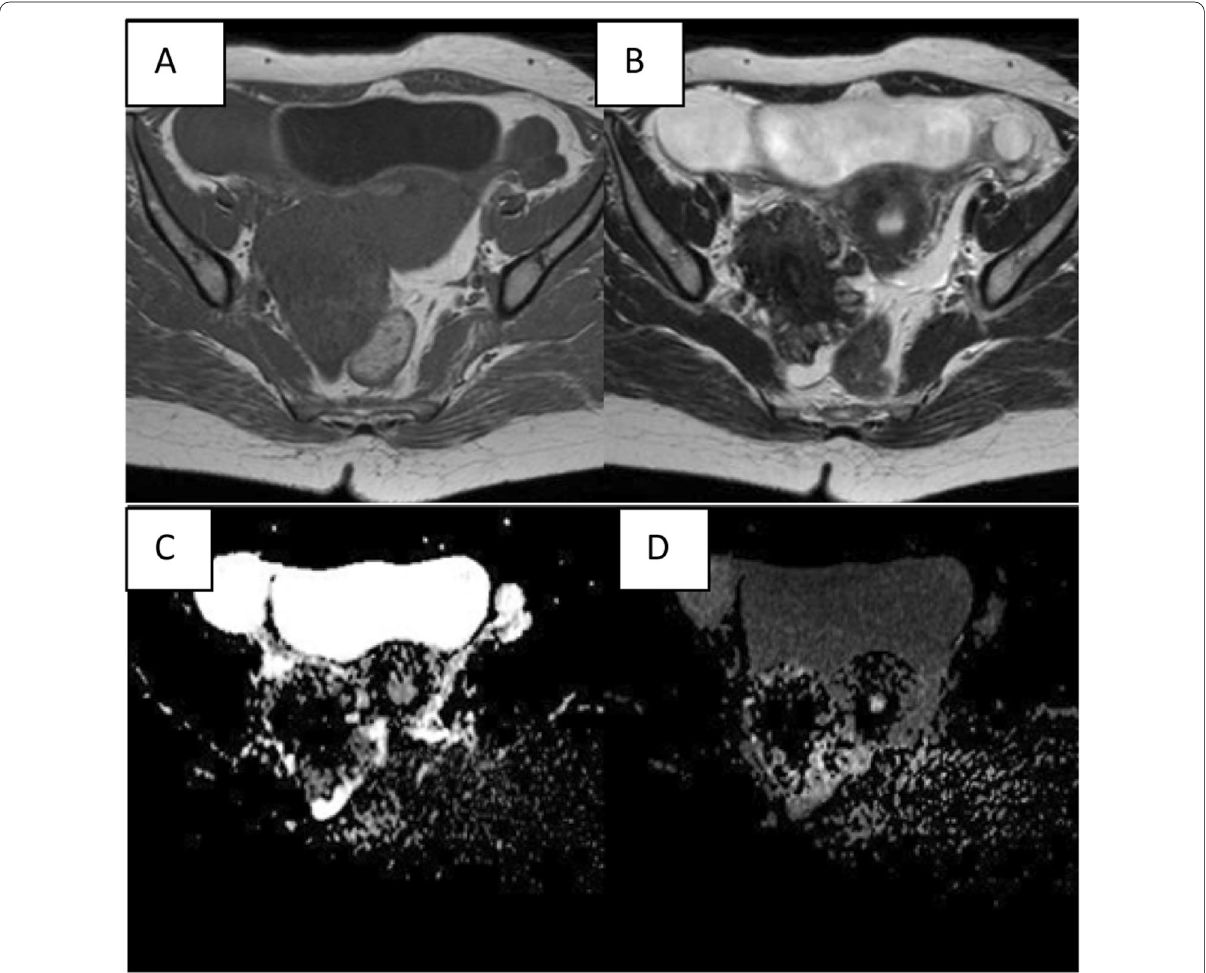
Fig. 4 A 40-year-old female came with irregular menstruation and lower abdominal pain. a , b MRI pelvis shows well defined T1 intermediate signal and T2 Hypointense mass with nodular surface in right adnexa. Low signal on T2WI depictsthe fibrous contents within the lesion, c , d lesion appear Hypointense on both DWI and ADC images. On post contrast, lesion shows delayed mild heterogeneous enhancement. Lesion is confirmed as Fibrothecoma by